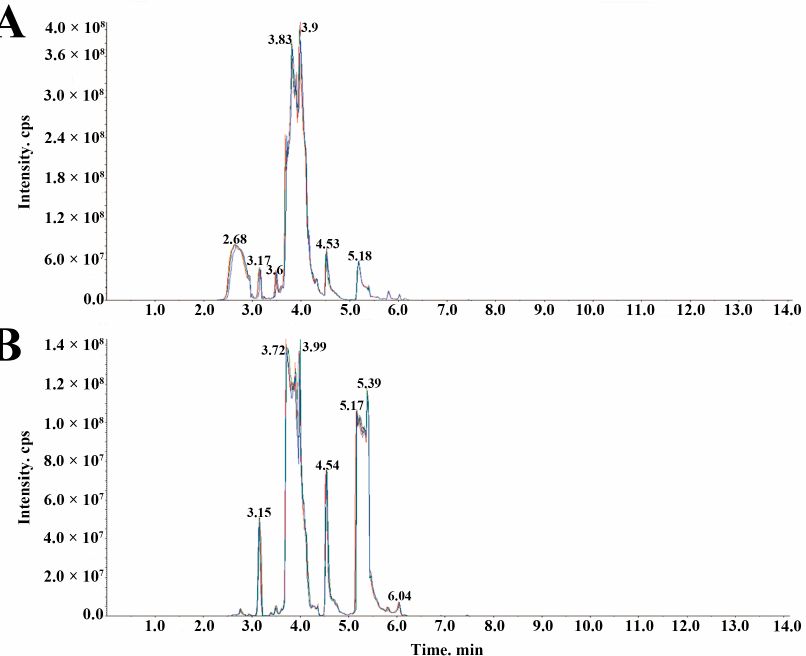
Figure 6. The stacking diagram of total ions current (TIC) maps from quality control samples (QC) mass spectrometry. ( A ) TIC of positive ion multiple reaction monitoring (MRM). ( B ) TIC of negative ion MRM.